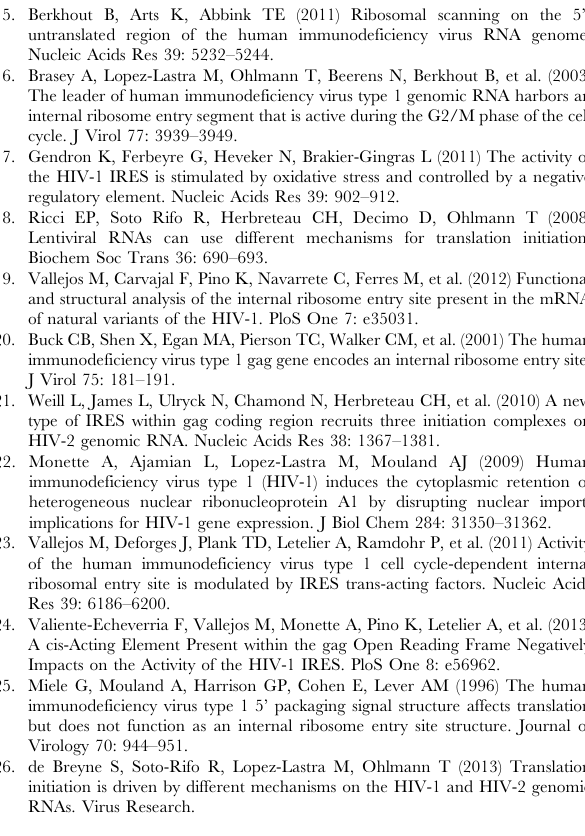
Figure S1 Titration of the poliovirus inoculum. Various concentrations of cell-free poliovirus were used to determine the poliovirus inoculum to elicit a maximum effect on total protein synthesis in cells. 293T cells were incubated with increasing quantities of poliovirus inoculum as described in Materials and Methods. Cells were pulsed with . 400 m Ci [35S] Trans-Label (Amersham) for 2–3 hours in Met- and Cys-free DMEM. Trichloroacetic acid-precipitable counts (TCA) as a measure of protein synthesis were estimated by liquid scintillation counting.